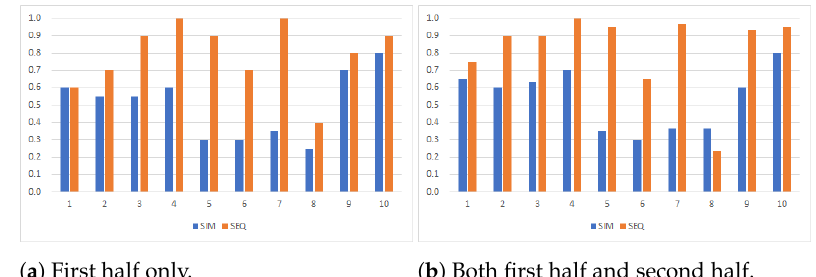
Figure 1. Frequency of reaching the